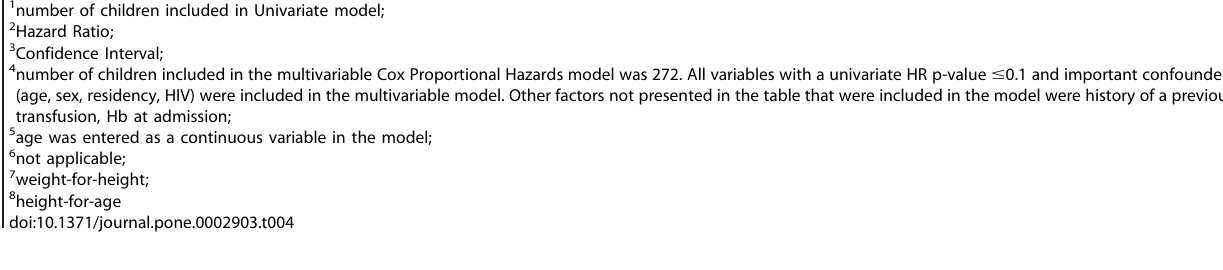
vs. 339/761 CC , p = 0.002). During the follow-up period, a higher proportion of cases were re-admitted to hospital (64/373, 17.2%) as compared to HC (35/371, 9.4%, p = 0.007) and CC (34/341, 10.0%, p = 0.01). These proportions were not significantly different between the HC and CC (p = 0.8).